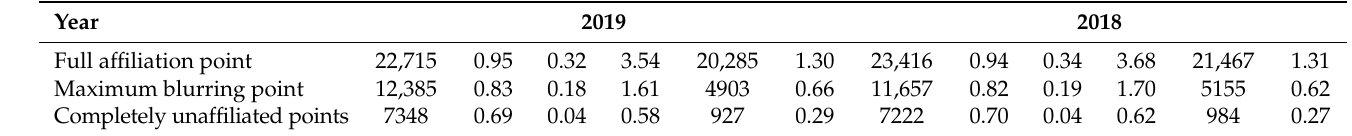
Table 5. Anchor setting reference points.